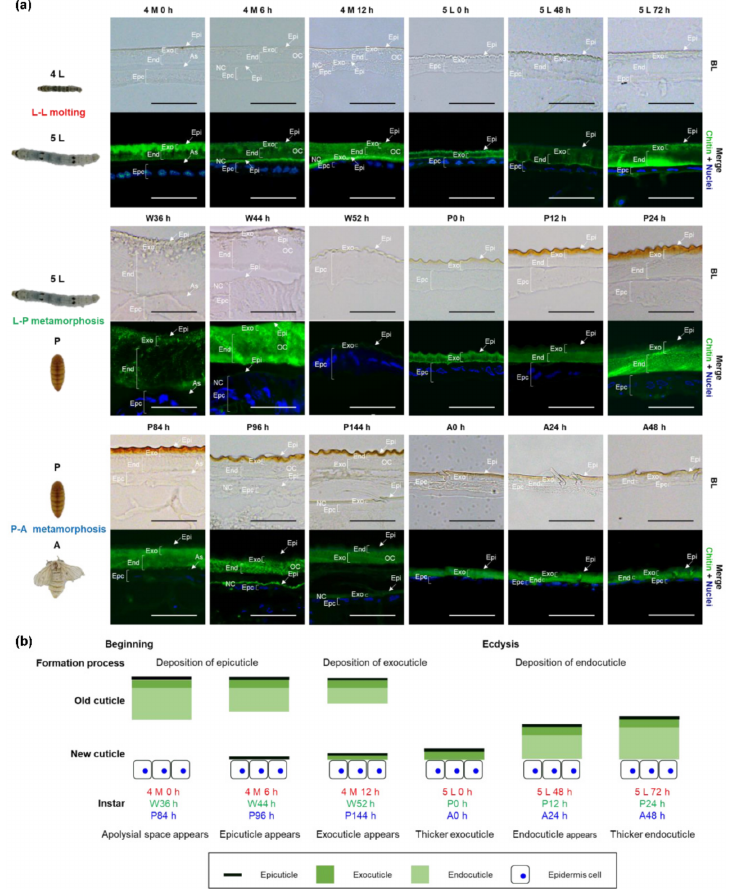
Figure 1. Microstructures and formation processes of larval, pupal, and adult cuticles in Bombyx mori . ( a ) Cuticle microstructures at representative time points. L-L molting: larval molting occurred from 4th instar larva (4 L) to 5th instar larva (5 L); L-P metamorphosis: larval metamorphosis occurred from 5 L to pupa (P); P-A metamorphosis: pupal metamorphosis occurred from P to adult (A); 4 M 0 h, 6 h, 12 h: 4th instar molting 0 h, 6 h, 12 h; 5 L 0 h, 48 h, 72 h; 5th instar larva 0 h, 48 h, 72 h; W36 h, 44 h, 52 h: wandering 36 h, 44 h, 52 h; P0 h, 12 h, 24 h, 84 h, 96 h, 144 h: pupa 0 h, 12 h, 24 h, 84 h, 96 h, 144 h; A0 h, 24 h, 48 h: adult 0 h, 24 h, 48 h; As: apolysis space; OC: old cuticle; NC: new cuticle; Epi: epicuticle; Exo: exocuticle; End: endocuticle; Epc: epidermal cells; Chitin: green; Nuclei: blue; Scale bar = 50 µ m. ( b ) Schematic representation of the formation processes of larval, pupal, and adult